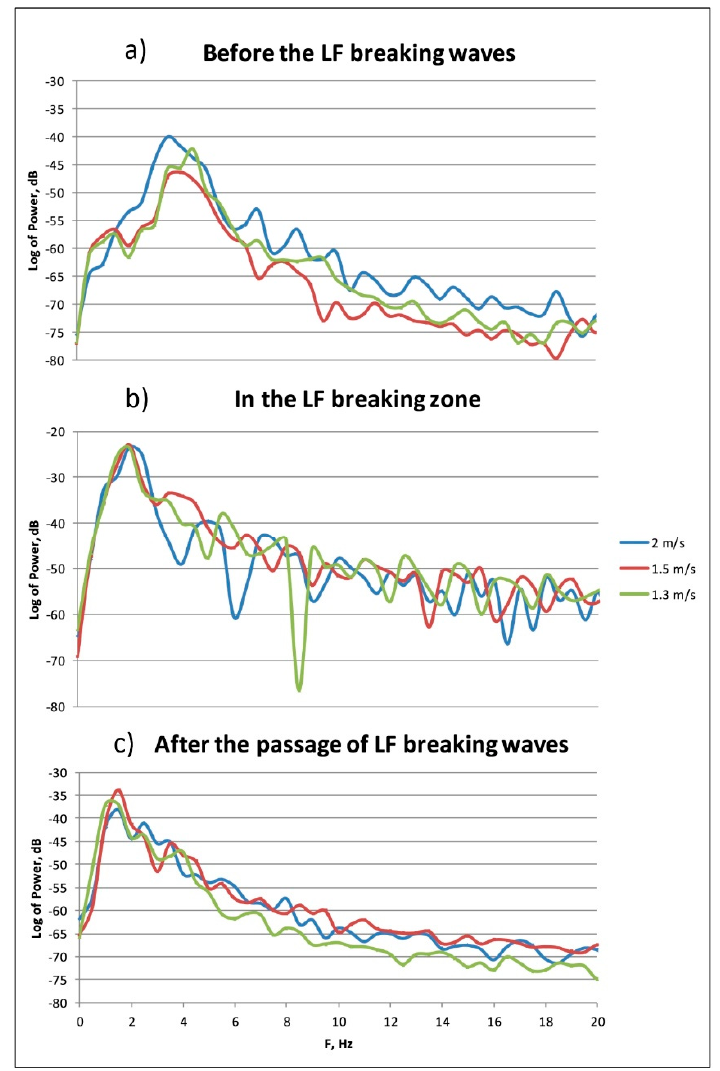
Figure 10. Typical spectra of surface waves spectra before breaking waves ( a ), in the wave breaking zone ( b ), and in the area of wind wave suppression after the passage of breaking waves ( c ).